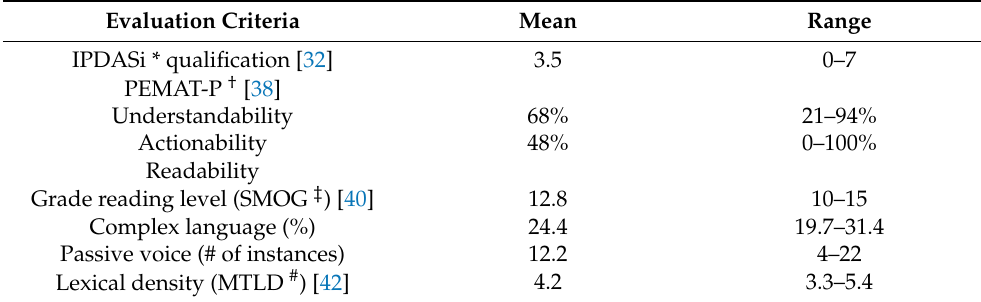
Table 2. Evaluation of online